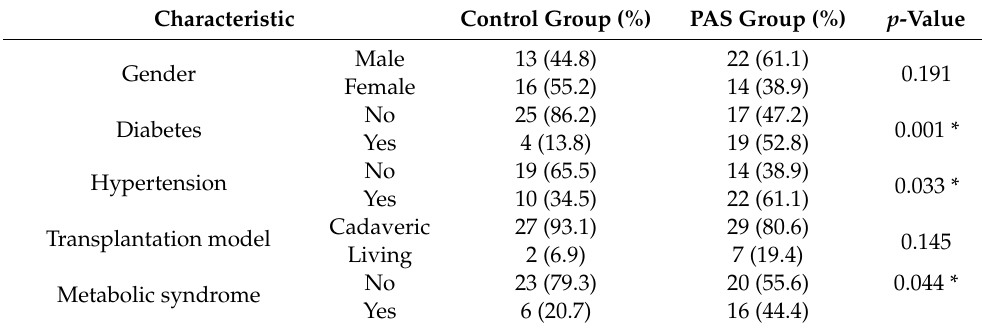
Table 2. Baseline characteristics of the 65 renal transplant recipients with or without peripheral arterial sti ff